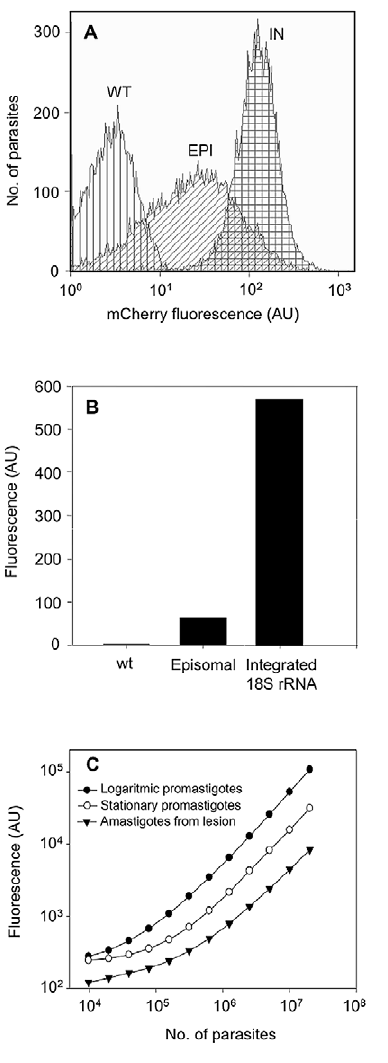
Figure 2. mCherry gene is functionally expressed in L. major parasites. Wild type (WT), pLEXSY episomal- (EPI) and integrated- (IN) mCherry expressing promastigotes were grown in the presence of hygromycin B and fluorescence levels were measured by flow cytometry. A) Histogram plot representative of the distribution of mCherry fluorescence levels in different populations of cells. B) Mean fluorescence intensity emitted by WT and the engineered parasite strains. The fluorescence is expressed as arbitrary units (AU). C) N Correlation between fluorescence signal and the number of logarithmic ), metacyclic promastigotes ( # ) and freshly isolated promastigotes ( amastigotes ( m ) of mCherry + L. major . Two-fold serial dilutions were applied and parasites were counted using a Coulter